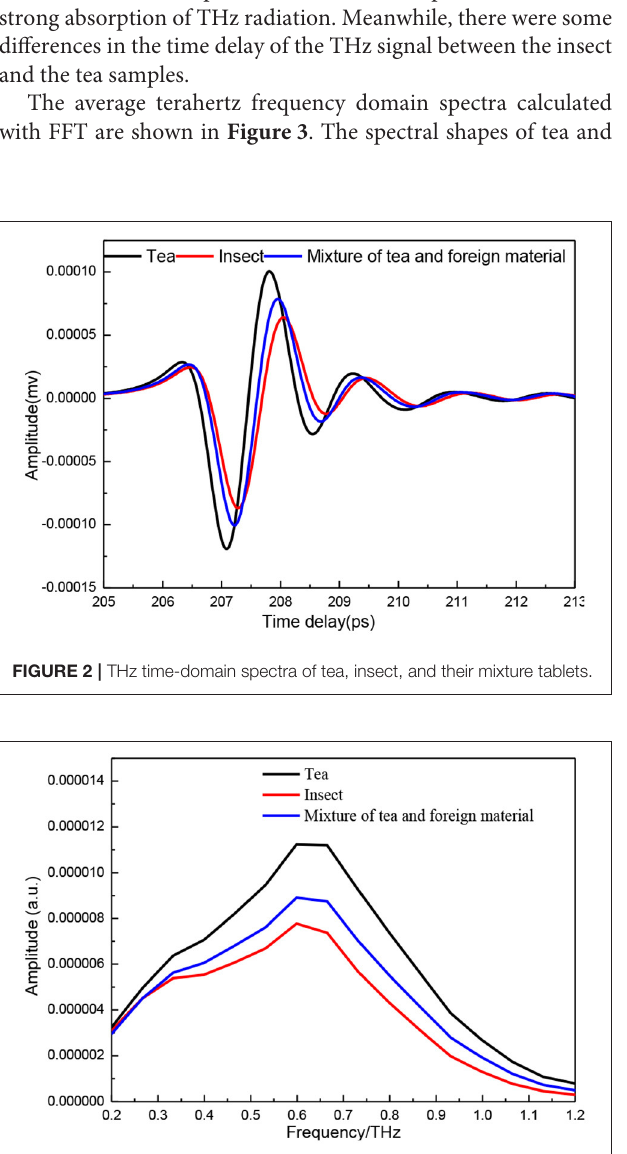
FIGURE 3 | Frequency-domain spectra of tea, insect, and their mixture